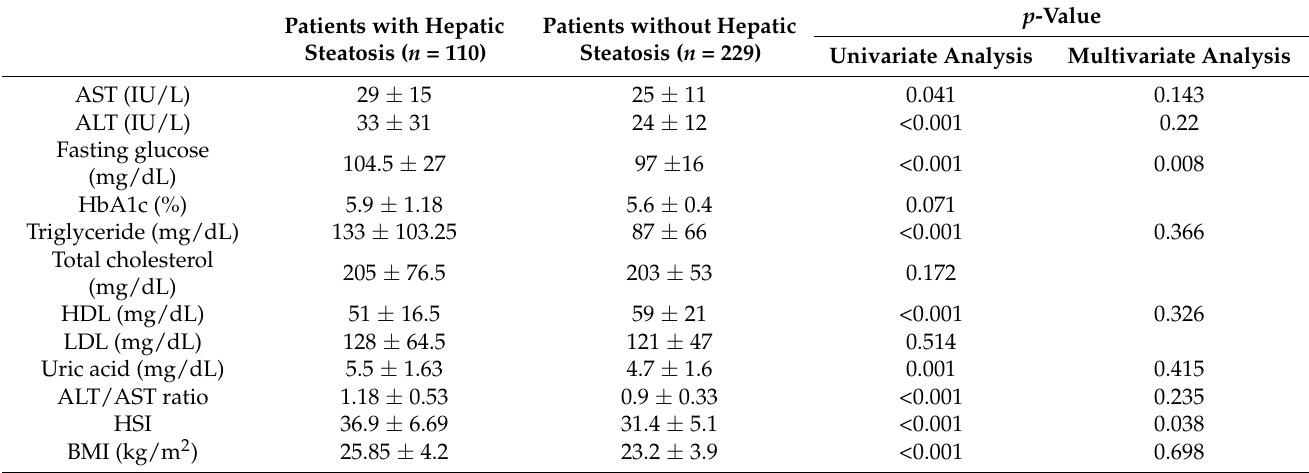
Table 1. Comparison of clinical parameters between the two groups determined by the hepatic steatosis criterion (a; HU liver < 48).